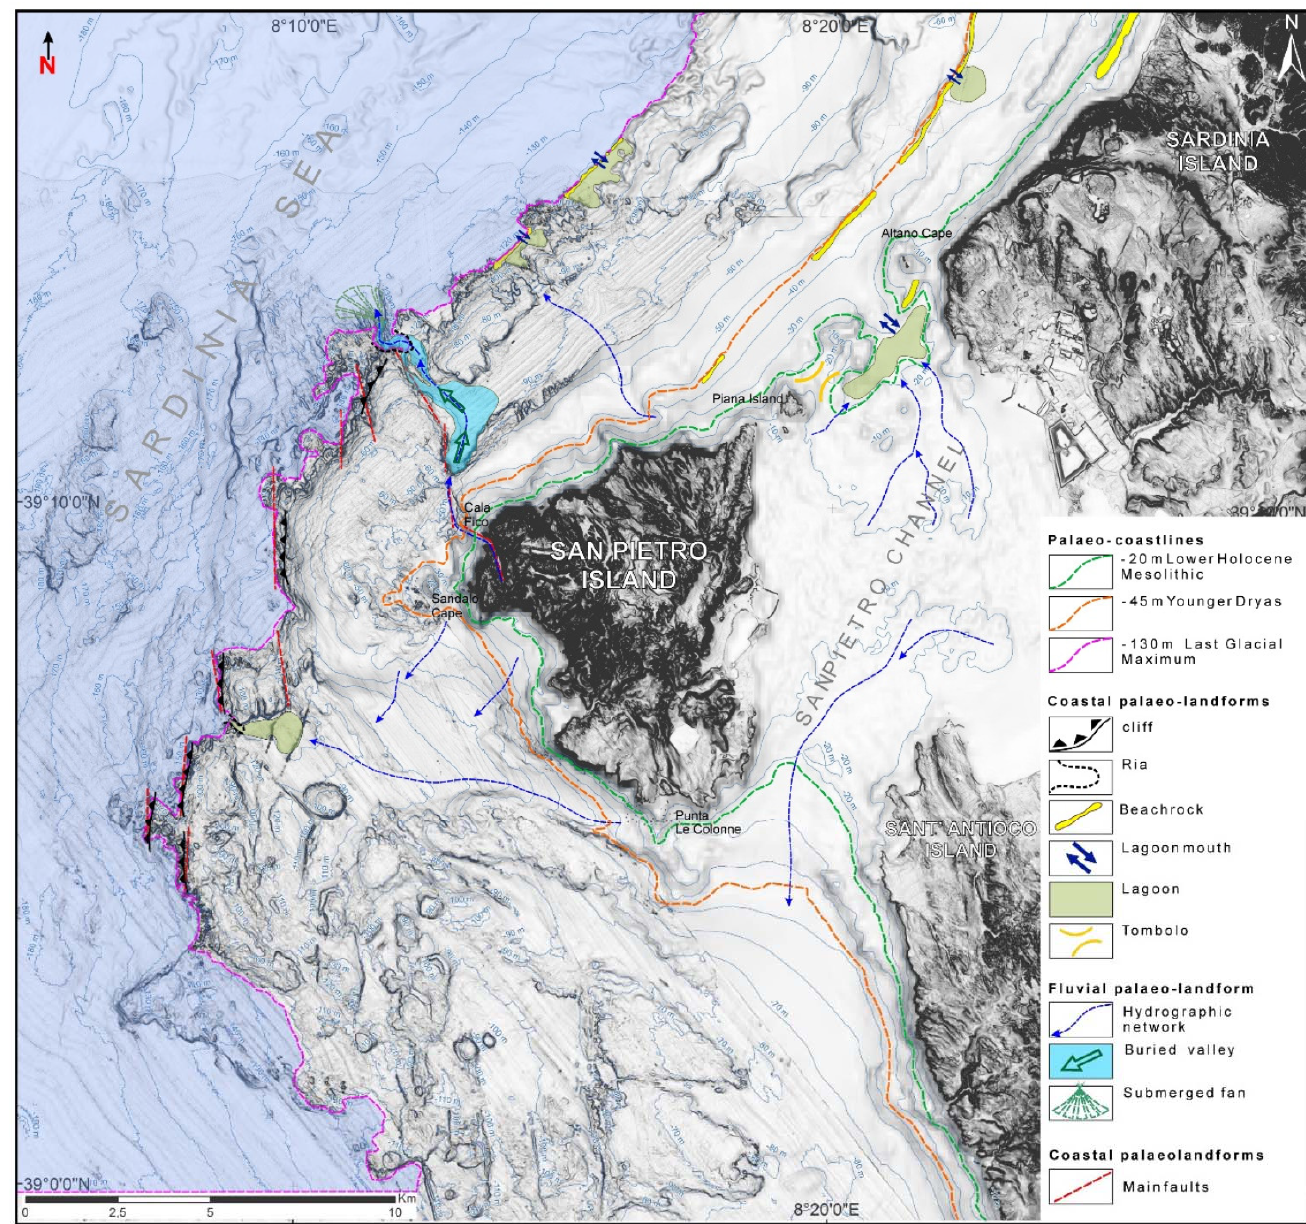
Figure 3. Geomorphological sketch of the San Pietro continental shelf. Submerged paleo-landscape from LGM (20 ka) to 9 ka [112].